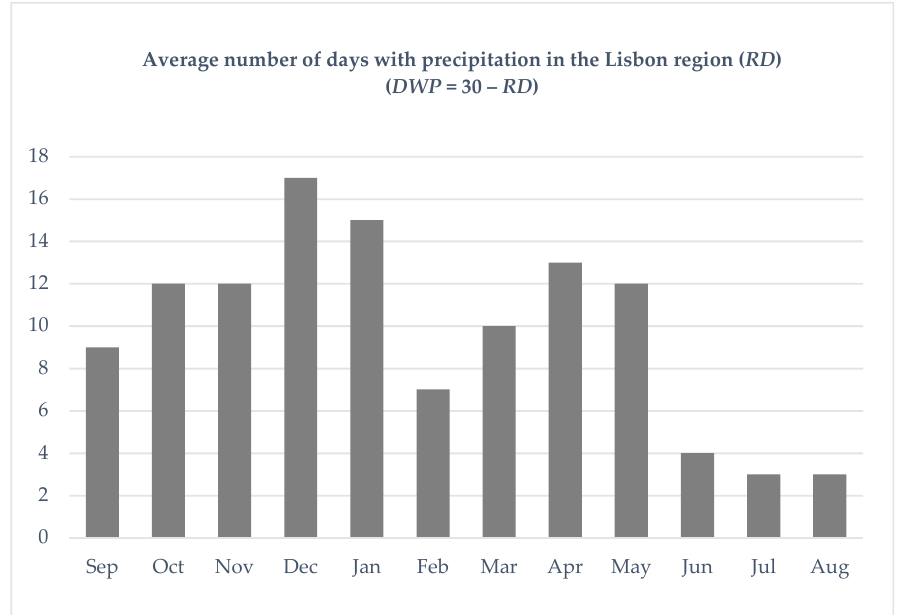
Figure 3. Rainfall days ( RD ) in the Lisbon region.